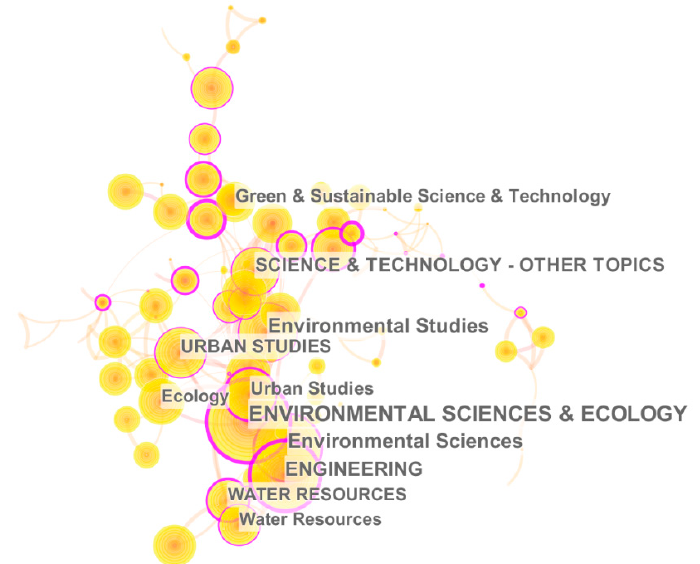
Figure 7. Distribution of main research disciplines.